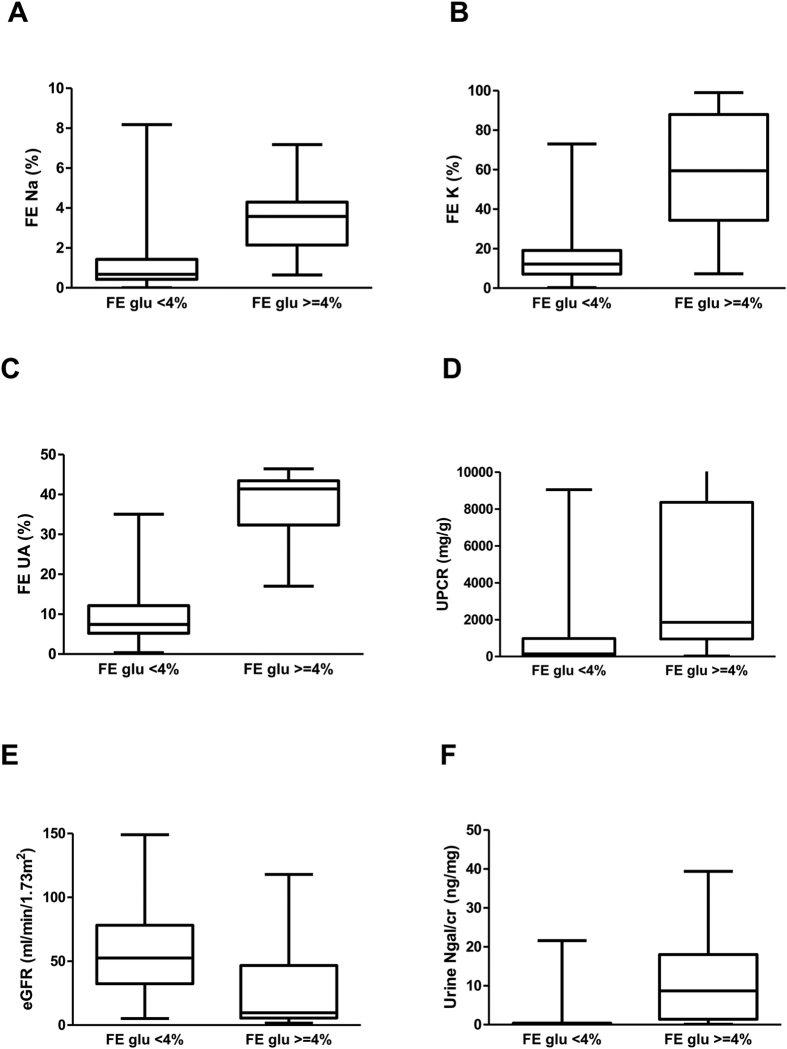
The median values and interquartile ranges of fractional excretion of sodium (FE Na), postassium (FE K), uric acid (FE UA), urine protein-creatinine ratio (UPCR), estimated glomerular filtration rate (eGFR) and urine neutrophil gelatinase-associated lipocalin – creatinine ratio (Ngal/Cr) in patients with FE glucose <4% and FE glucose ≥4%.All P values < 0.05 for Mann-Whitney U test between two groups through A to F.